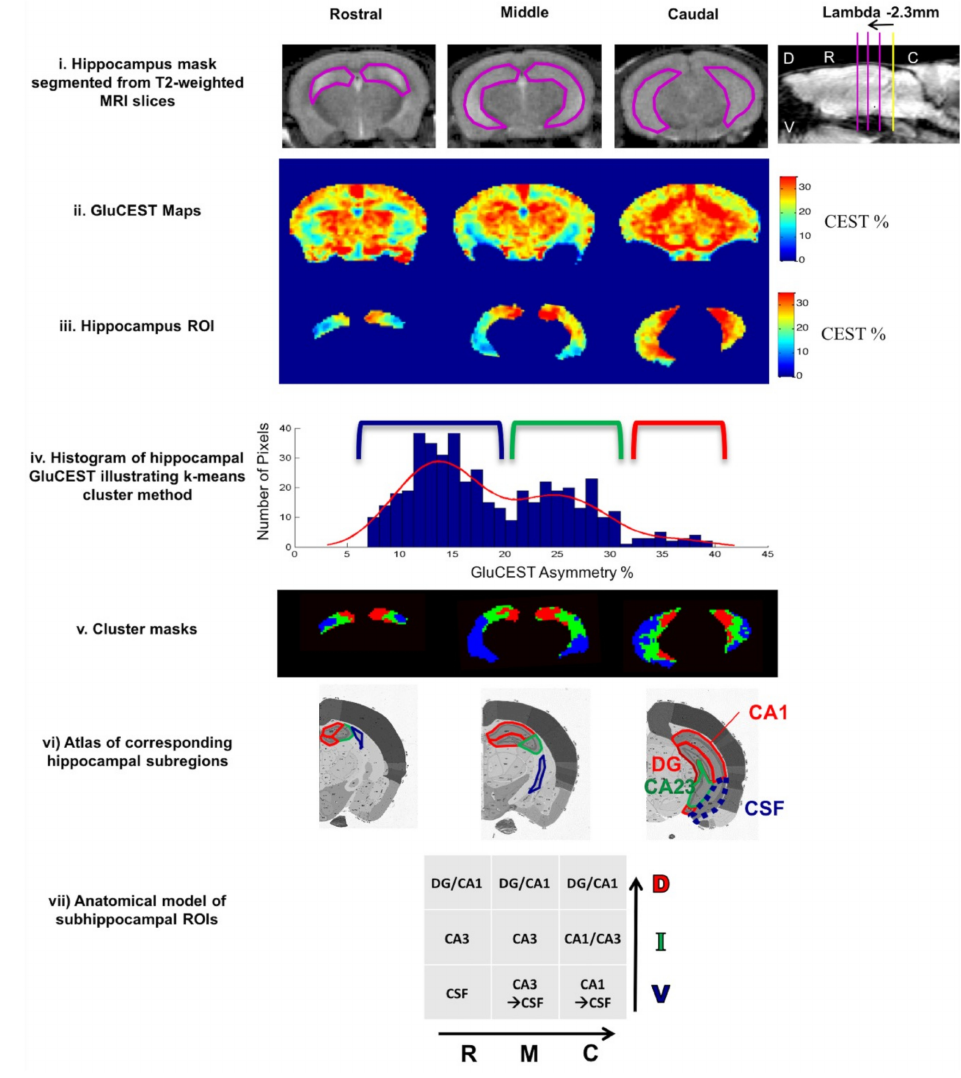
Figure 4. Image acquisition and segmentation pipeline for gluCEST imaging of mouse brain. ( i ) Anatomical T 2 -weighted magnetic resonance images (MRI) acquired from a live mouse brain. The example images shown here are from a 3 month old PS19 mouse. Slice positions were chosen relative to the lambda marker (yellow) identified on the sagittal scout image. The three slices (1-mm thick each) span the hippocampus from rostral to caudal. ( ii ) gluCEST asymmetry maps represent gluta- mate levels in vivo with high spatial resolution (156 µ m 2 inplane). Gray matter regions such as the thalamus have higher glutamate levels, compared to white matter regions like the corpus callosum where glutamate levels are low. ( iii ) Hippocampus proper segmented from the T 2 -weighted MRI and applied to gluCEST maps represents the hippocampus region of interest (ROI). ( iv ) Histogram of gluCEST values in an example slice of the hippocampus. The k-means clustering algorithm segments three “clusters” or subregions within the hippocampus based on high, medium, and low gluCEST values. ( v ) The three clusters are anatomically correlated to the dorsal (D, red), intermediate (I, green), and ventral (V, blue) hippocampus. The cluster mask displays the final subhippocampal ROIs. ( vi ) Three corresponding slices of the hippocampus from the Allen Brain Atlas [164]. Hip- pocampal subregions of interest are outlined: dentate gyurs (DG), cornu ammonis (CA1 and CA3), and the cerebral spinal fluid (CSF). Each region is colored to indicate their approximate cluster position. ( vii ) An approximate anatomical model of the subhippocampal ROIs which contribute to each cluster (dorsal, intermediate, ventral) in each slice (rostral, middle, caudal). In younger mice the CA1 extends through the caudal–ventral hippocampus, which later becomes CSF as mice age (arrow). © Crescenzi et al., 2017 [157], reproduced under permission of John Wiley and Sons, Inc. license no